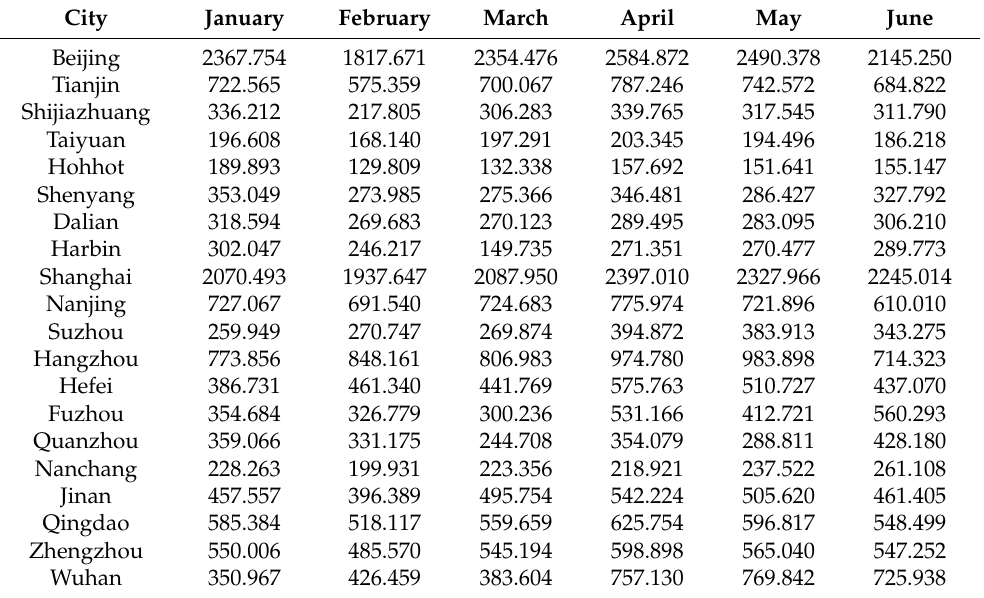
Table 7. GDP of cities in the tertiary industry from January to June 2020 (unit: 100 million yuan).